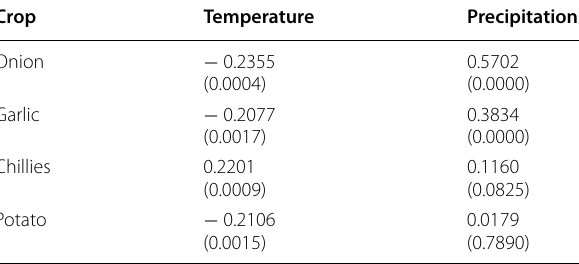
Table 5 Correlation between climatic variables and crop yield indicates a significant relationship between the climatic change and the yield of crops